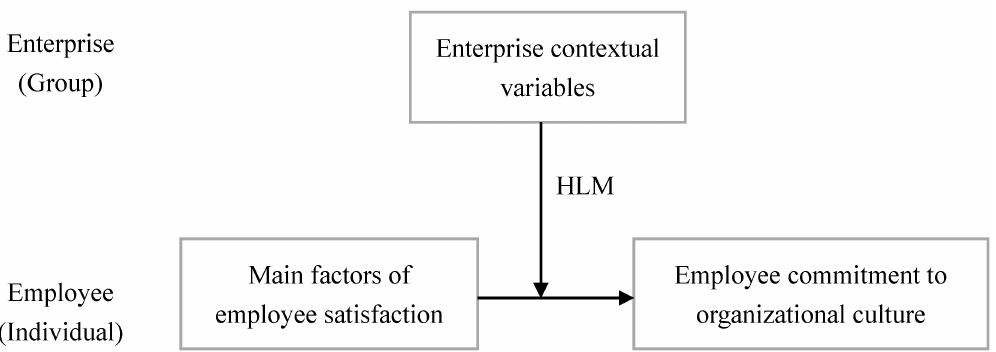
Figure 1. Conceptual framework of employee satisfaction, commitment to organizational culture, and contextual variables.